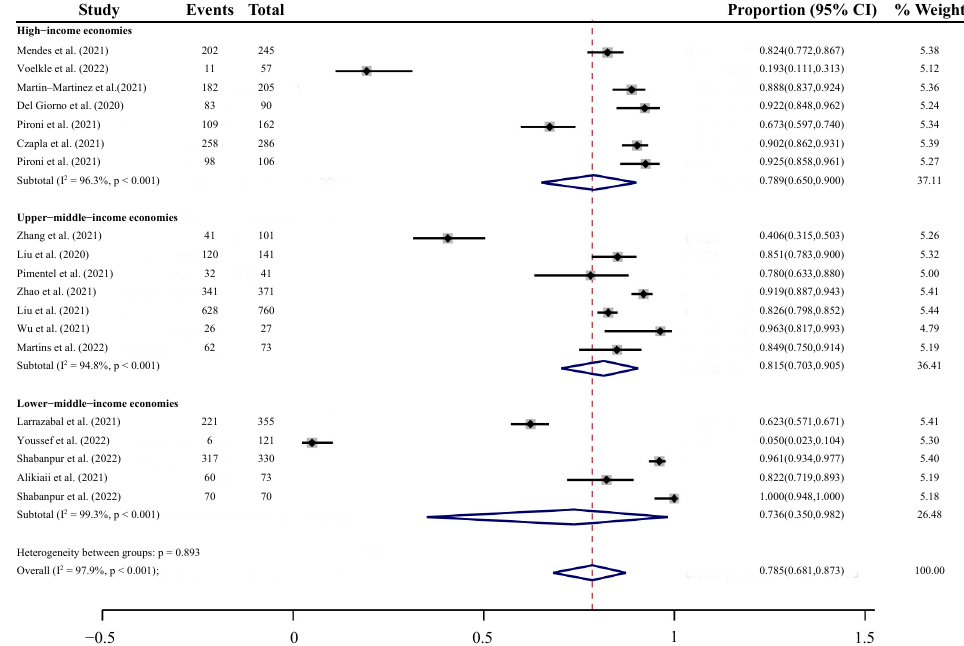
Figure 5. Subgroup Analysis of the Prevalence of Malnutrition in COVID-19 Patients by World Bank country classifications by income level [36–52]. High-income economies: Switzerland, Spain, Italy, and Poland; Upper-middle-income economies: China and Brazil; Lower-middle-income economies: Philippines, Egypt, and Iran.